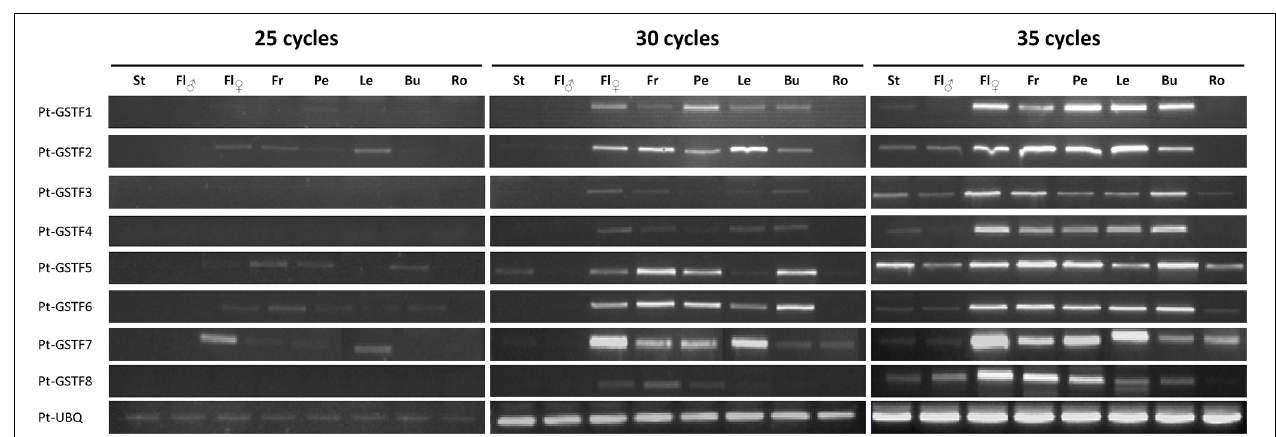
FIGURE 3 | Transcript accumulation of GSTFs in poplar organs. RT-PCR experiments were performed using cDNAs from stamens (St), male flowers (Fl ♂ ), female flowers (Fl ♀ ), fruits (Fr), petioles (Pe), leaves (Le), buds (Bu), and roots (Ro). Ubiquitin was used as a reference gene.